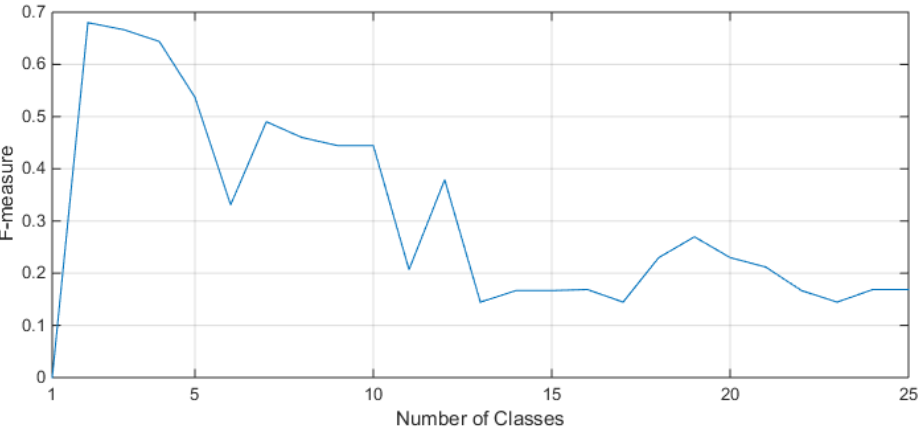
Figure 9. Influence of the number of classes for the F-measure of the fractal fuzzy C means method.